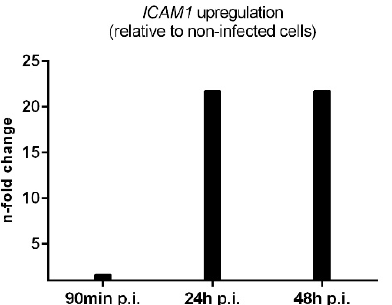
Figure 7. Delta C q values of ICAM1 in noninfected and infected endothelial cells. Normalized data using ( A ) GADPH and ( B ) β -actin . Bars indicate the std dev of five independent experiments.